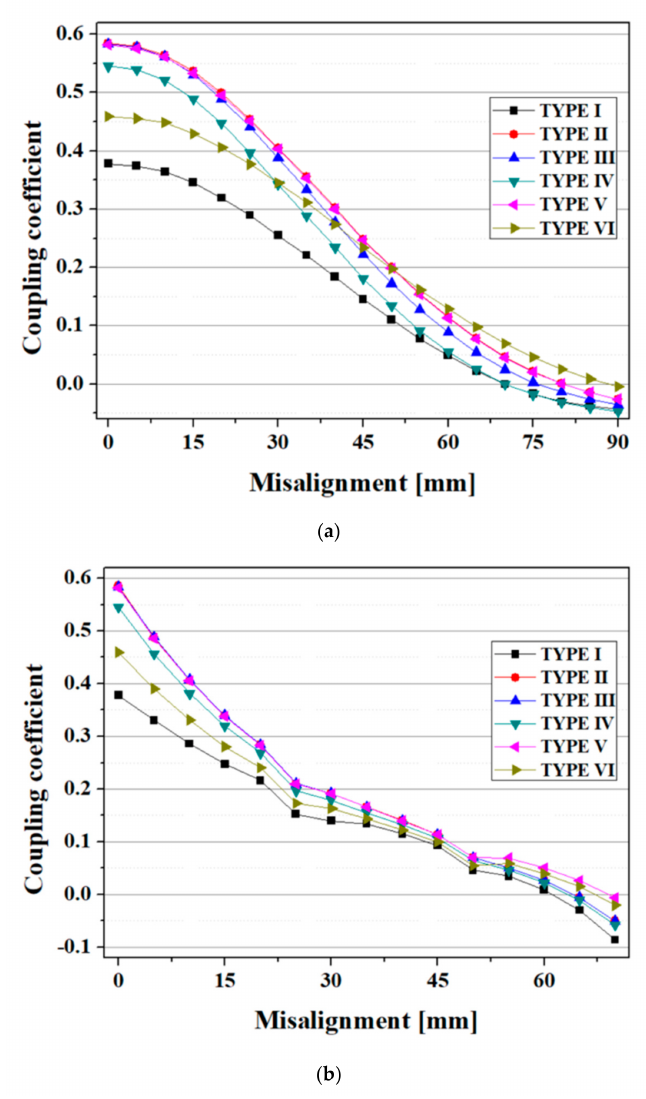
Figure 9. Variation of the coupling coe ffi cient and structure according to a misalignment: ( a ) X-axis misalignment, and ( b ) Y-axis